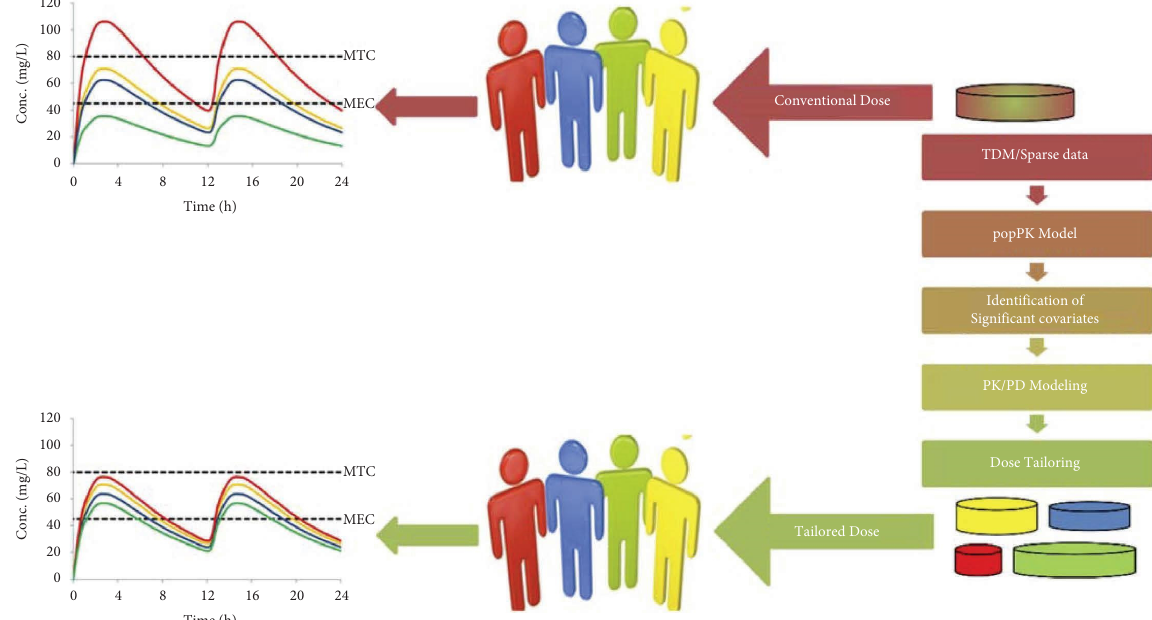
Figure 3: Flow diagram for population pharmacokinetic modeling.